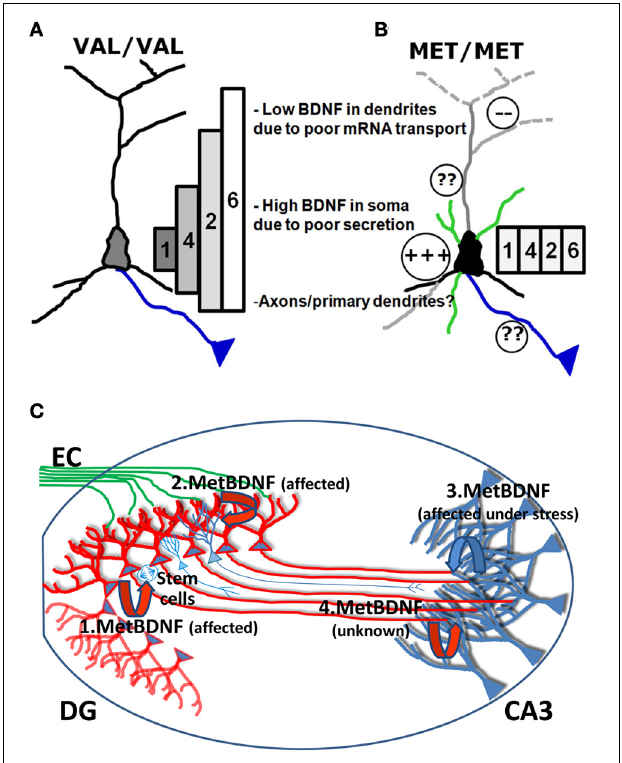
FIGURE 2 | Model of the biological effects of Val and Met BDNF alleles in the hippocampus. (A) In Val/Val neurons, the four most abundant brain BDNF transcripts, encoding exon 1, 2, 4, or 6, are differentially localized in dendrites, forming a gradient with exon 1 being restricted to the soma and exons 2, 4, and 6 in dendrites at increasing distances according to the gradient 4 < 2 < 6. Exons 1 and 4 can affect only the morphology of proximal dendrites while exon 2 and 6 are able to shape the distal dendrites. (B) In Met/Met neurons, transport of BDNF mRNA in distal dendritic districts is impaired and all BDNF mRNA isoforms accumulate in the cell soma. Met BDNF protein increases in the soma, also due to poor secretion. It is unclear if axonal transport and secretion can be affected by the Met mutation. (C) BDNF released from DG granule cells is shown in red, while BDNF released from CA3 neurons is shown in blue. (1.BDNF) Secretion of Met BDNF from the soma of DG granule cells is altered and provides insufficient local trophic support for survival and differentiation of DG subgranular neural stem cells. (2.BDNF) Release of Met BDNF from dendrites of DG neurons is affected and cannot provide sufficient autocrine support to dendrites which show reduced arborization. (3.BDNF) Local production and release of Met BDNF from apical dendrites of CA3 neurons is reduced and cannot provide the target-derived trophic support to promote innervation of CA3 from newly formed mossy fibers and autocrine support to CA3 dendrites. (4.BDNF) It is unknown if anterogradely transported Met BDNF in mossy fibers can support dendrites from CA3 neurons and if anterograde transport of BDNF is affected by the Met